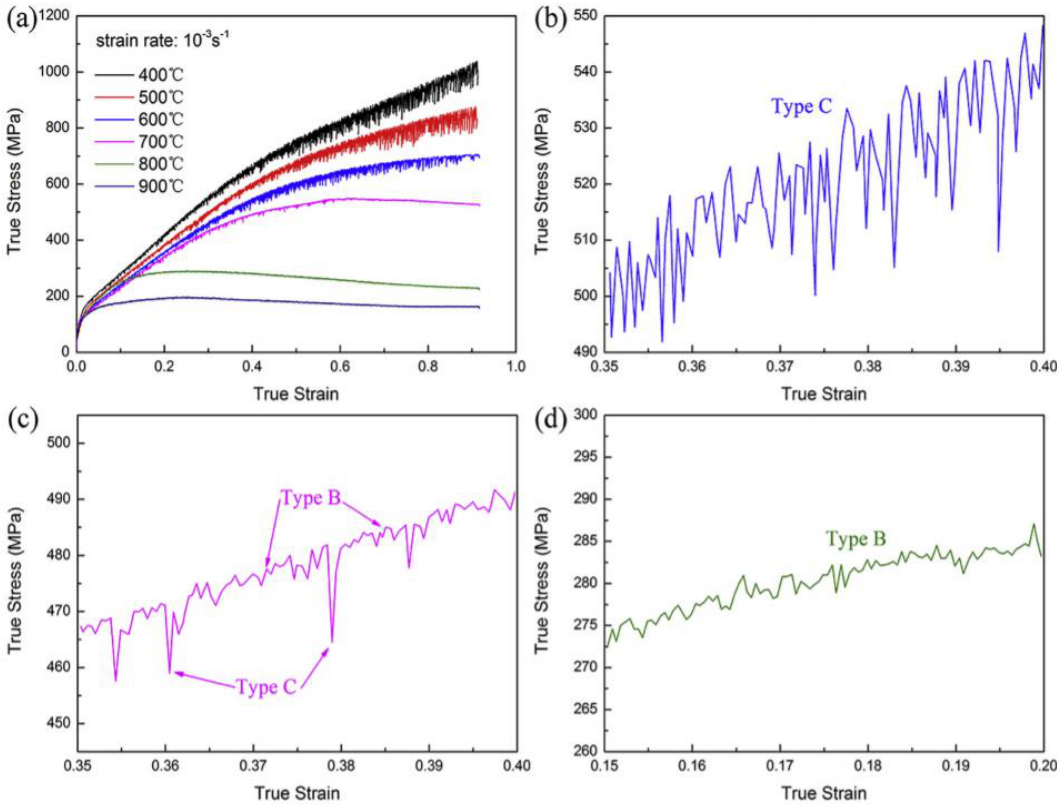
Figure 27. ( a ) True stress–strain curves of the Al 0.3 CoCrFeNi HEA tested at temperatures ranging from 400 to 900 °C and a strain rate of 10 −3 s −1 , and the magnified regions of the serrations at temperatures of ( b ) 600 °C, ( c ) 700 °C, and ( d ) 800 °C (reproduced from Reference [169] with permission). Table 3. Summary of the serration type exhibited by the Al 0.3 CoCrFeNi HEA during tension at a strain rate of 1 × 10 −3 s −1 and temperatures of 400–800 °C (from Reference [169]). Strain Rate (s −1 ) Temperature ( °C)